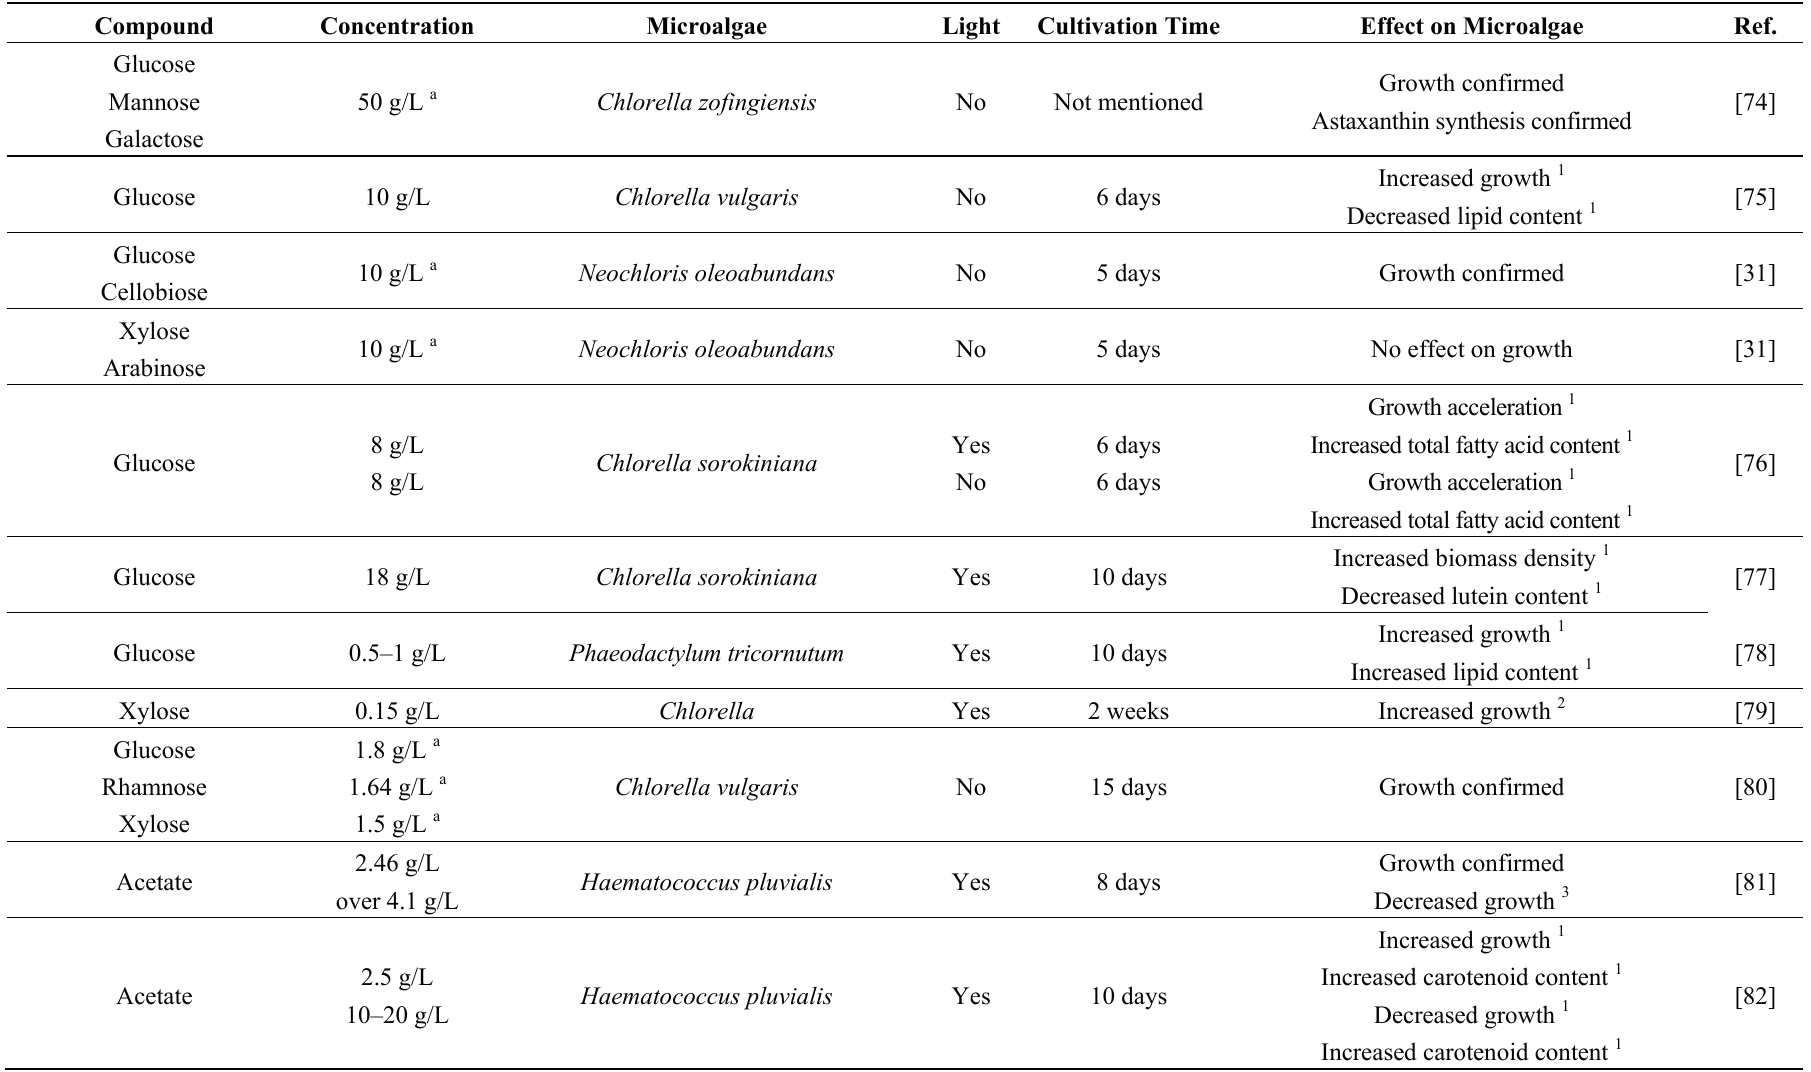
Table 5. Effect of lignocellulosic hydrolysate related compounds on microalgae under various cultivation conditions: a summary. Compound Concentration Microalgae Light Cultivation Time Effect on Microalgae Ref. Glucose